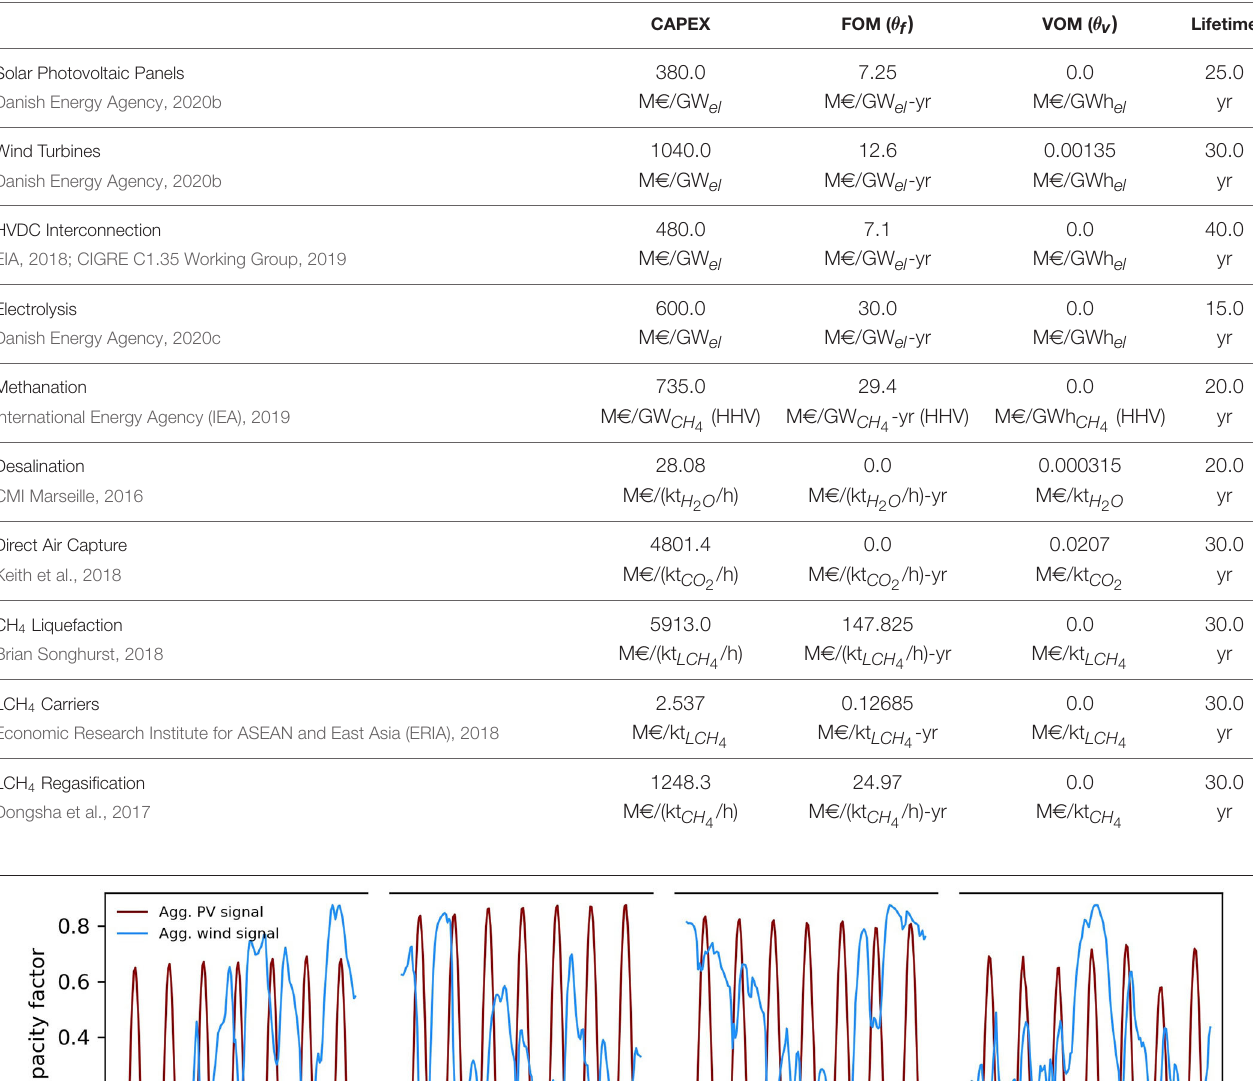
TABLE 2 | Economic parameters used to model conversion nodes (2030 estimates).